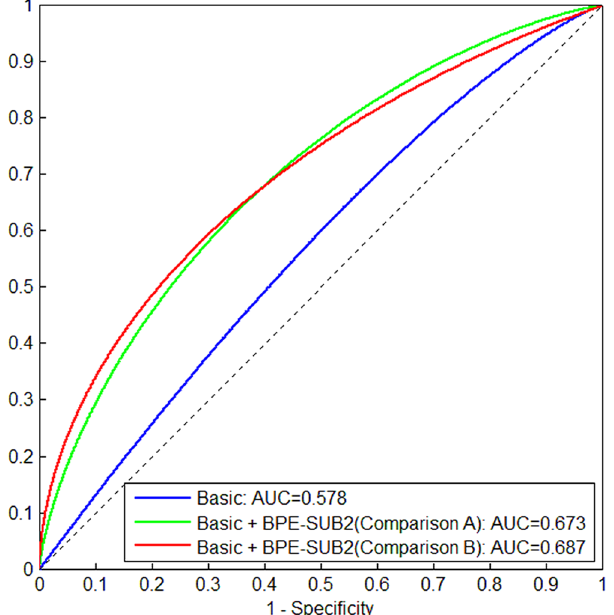
Figure 3. AUCs of distinguishing cancer cases from controls when using only four basic factors (i.e., age, menopausal status, family history, and ordinal mammographic density) and when the combination of |BPE| and BPE% computed from SUB2 were added to the four basic